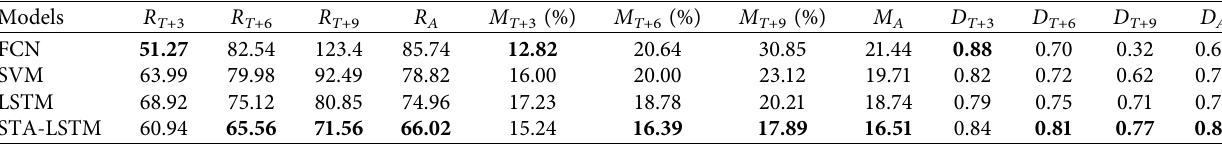
Table 3: Comparison experiments on Changhua dataset to test effectiveness of attention module. Note that bold and underline texts indicate best and secondary best performance among comparative methods, respectively. We define unit for M as %. Methods R T +3 With spatial With temporal Table 4: Comparisons on Lech dataset with several comparative methods. Note that bold texts indicate best performance among comparative methods.